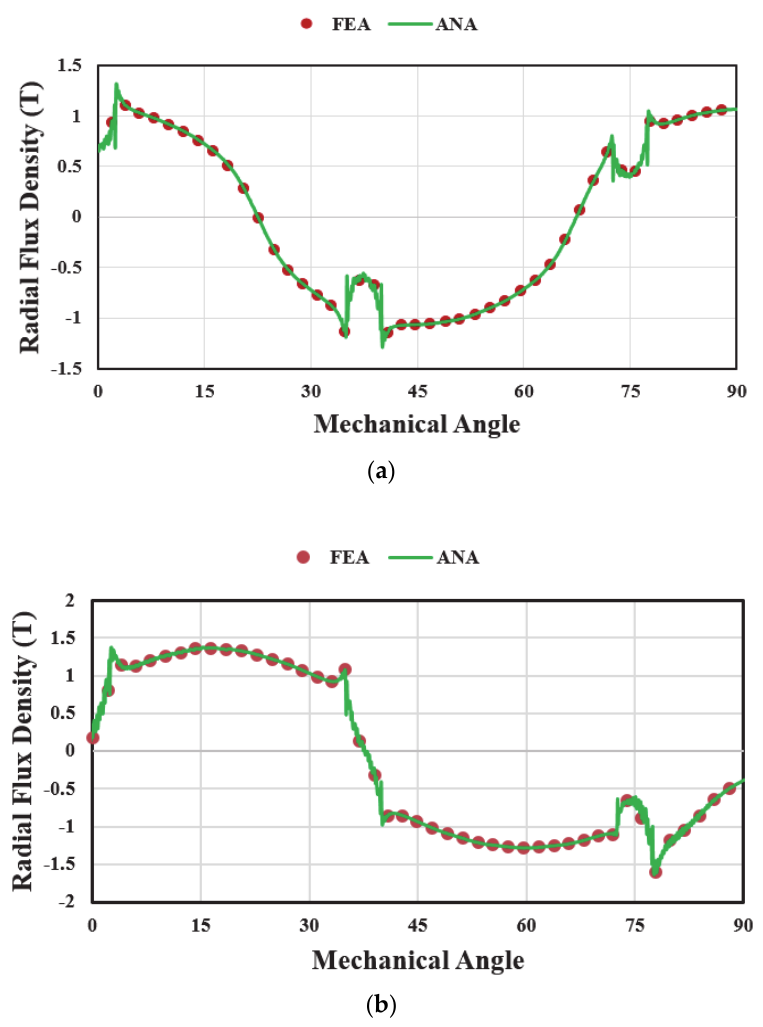
Figure 8. An analytical and numerical comparison of radial flux density for the 12S-10P motor. ( a ) Open circuit condition; ( b ) On-load condition.